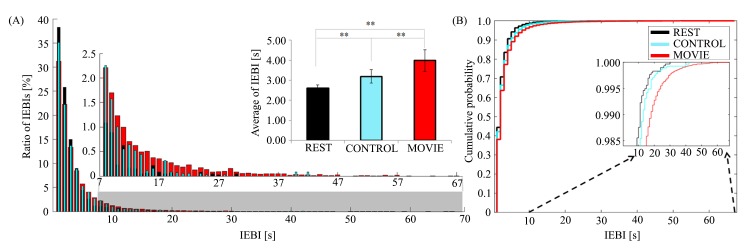
Statistical comparisons and cumulative distribution in three conditions.(A) The graph shows the average of IEBIs and histogram of IEBIs for each of the three conditions (Fig 2 and S1 Dataset). The portion of the histogram between 8 and 67 s has been magnified to more clearly illustrate the distribution of long IEBIs. (B) Cumulative distribution functions for each of the three conditions. The red, sky-blue and black lines show MOVIE, CONTROL and REST conditions, respectively. (p < 0.01** Denotes a statistically significant difference.)